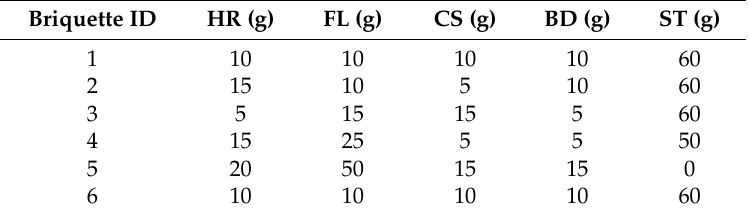
Table 2. Formulations for Briquette Molding.